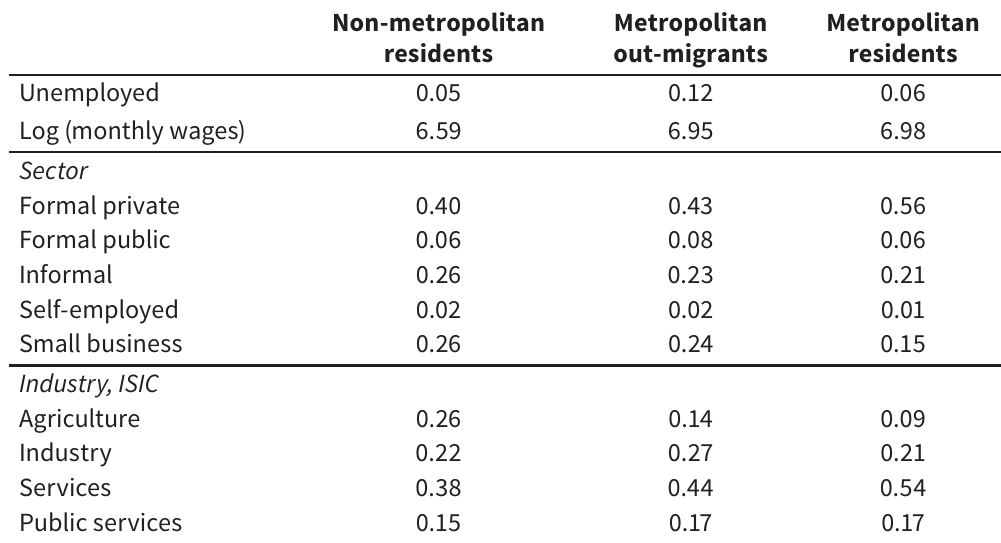
Labor market characteristics of migrants and non-migrants